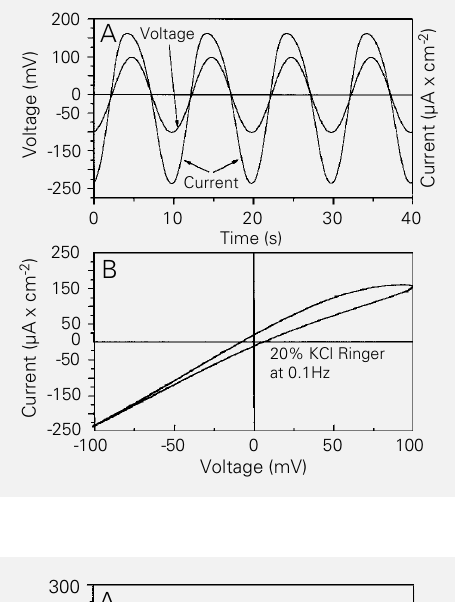
6 - Response to sinusoi- dal voltage at 0.1 Hz and [Cl - ] = 117 mM. A , Applied sinusoidal voltage and current response of the skin plotted against time in symmetrical KCl Ringer with [Cl - ] = 117 mM and frequency of 0.1 Hz. B , Current and applied voltage of A plotted against each